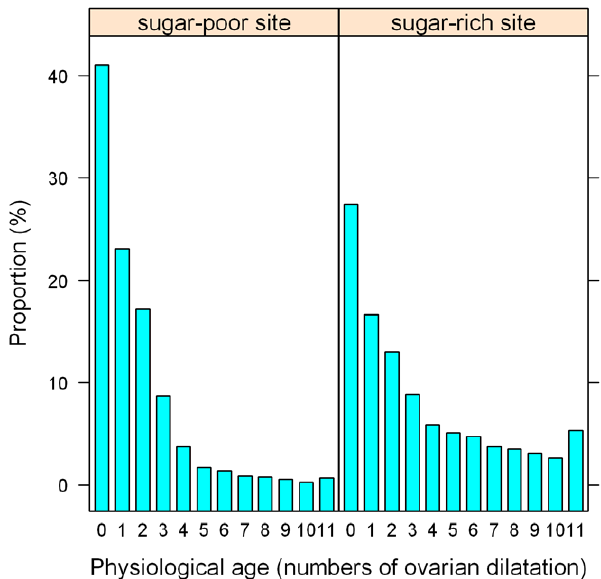
Figure 1. Totals (females + males) of marked and unmarked Anophelessergentii captured in two sites with different levels of sugar supply.